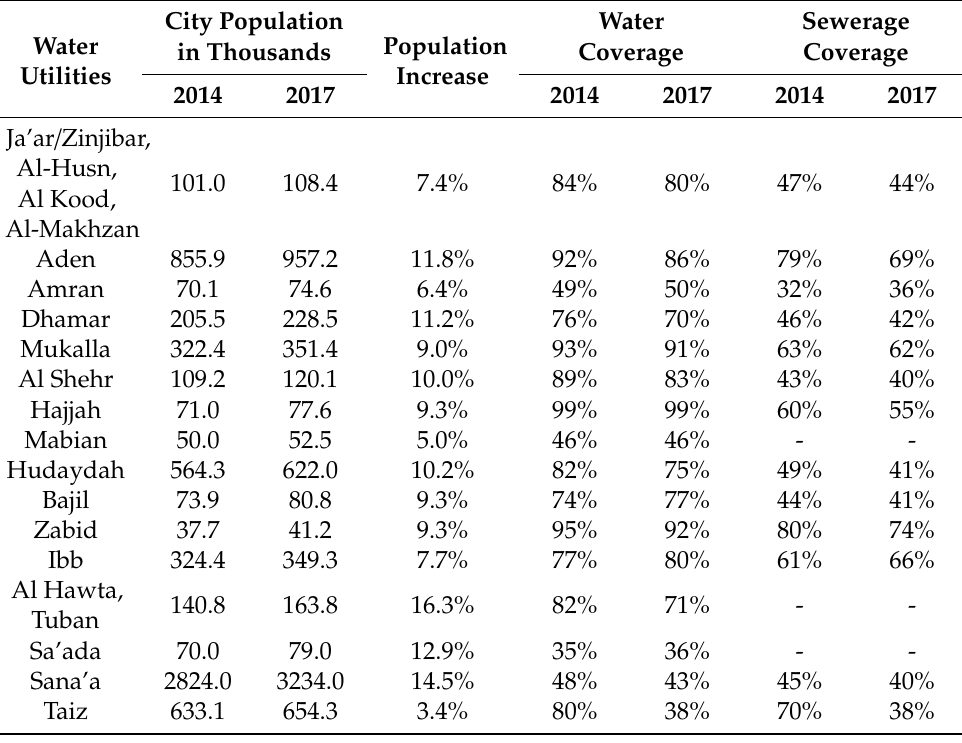
Table 3. Service coverage of major water utilities in 2014 and 2017, based on data from